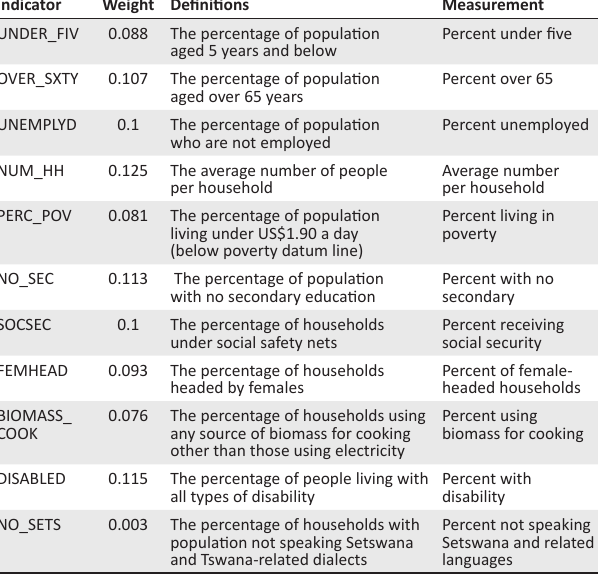
TABLE 5: Selected indicators and their weights, definitions and measurement.